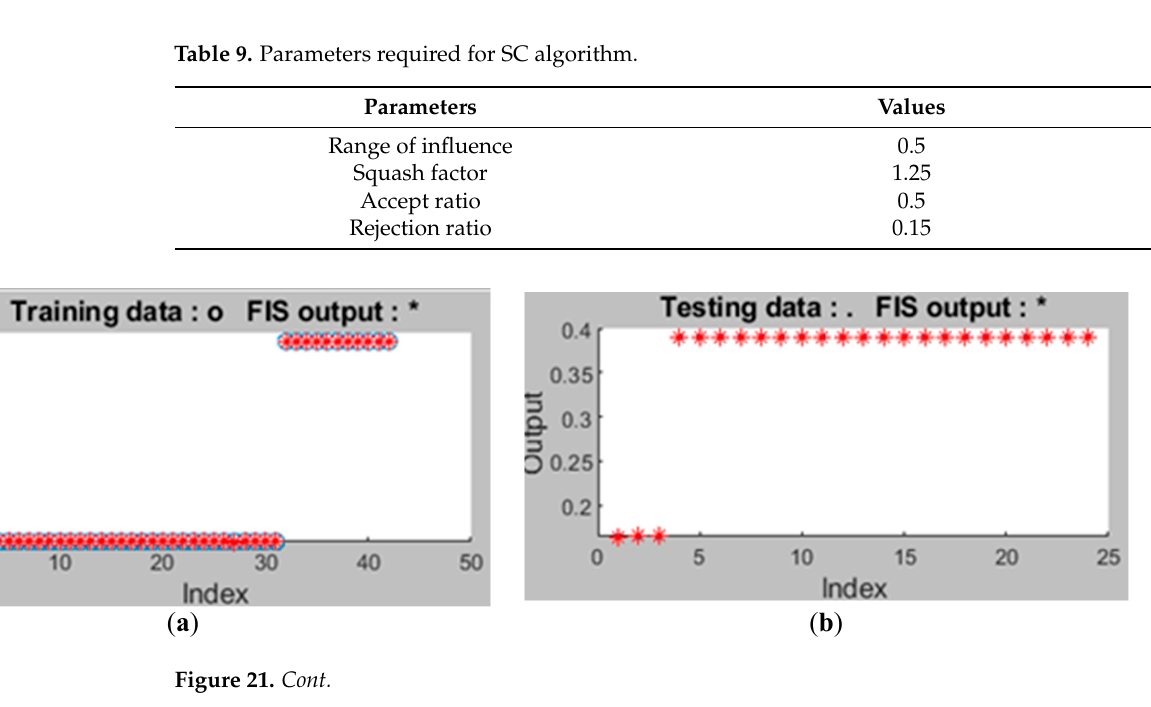
Table 9. Parameters required for SC algorithm.